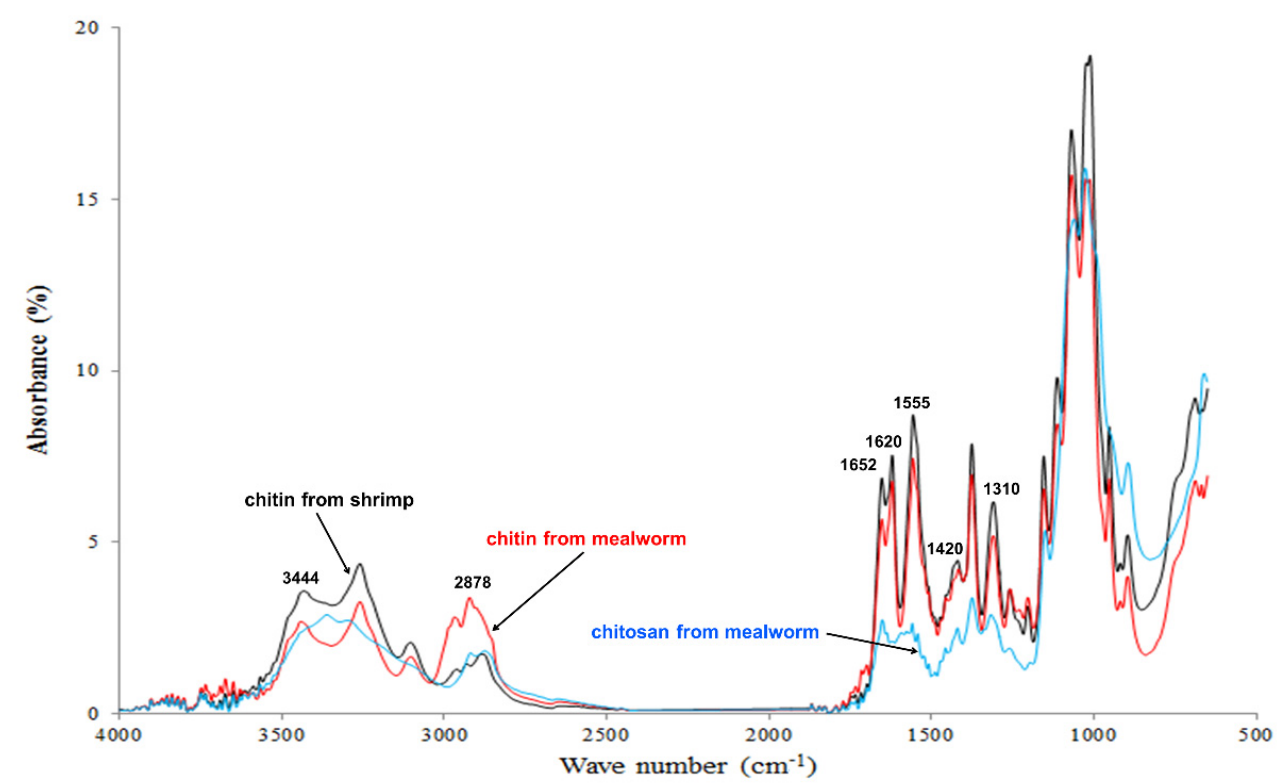
Figure 3. Fourier transform infrared spectroscopy (FT-IR) data of chitin and chitosan.